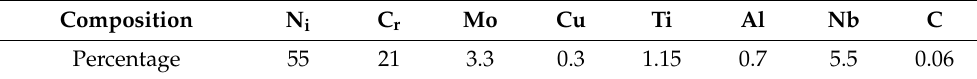
Figure 13. Schematic diagram of ECM system. Table 2. Composition table of high temperature nickel-based alloy GH4169.